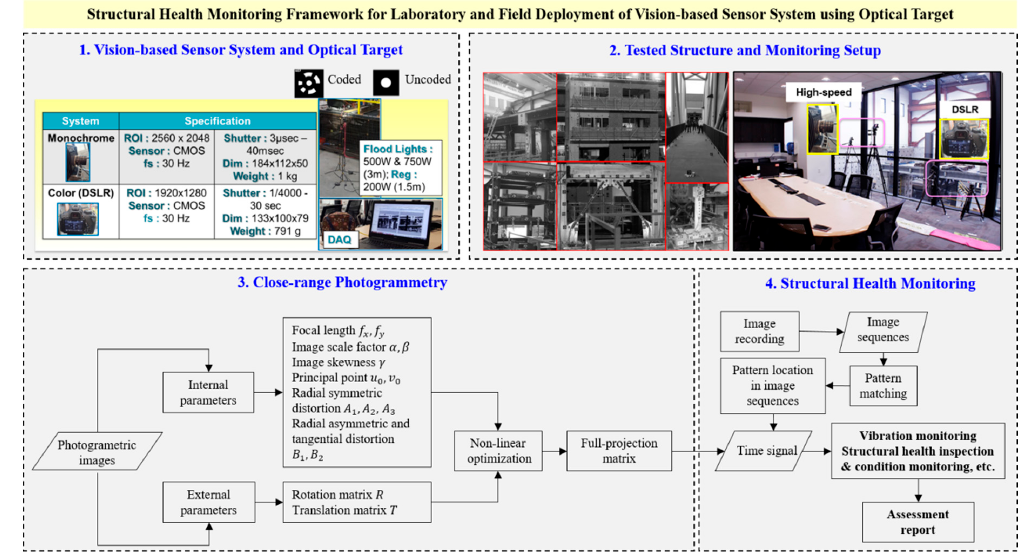
Figure 1. SHM framework and various components of vision-based sensor system for laboratory and field deployment using optical targets.